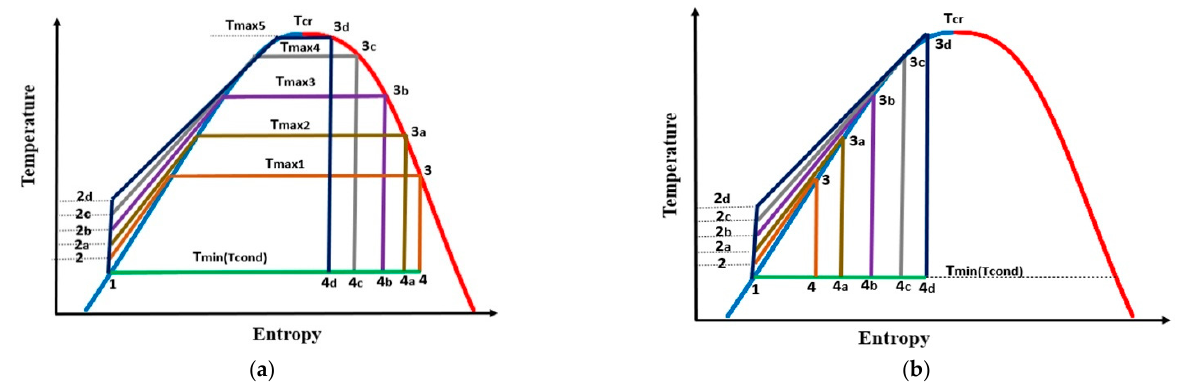
Figure 3. Steps of the efficiency-calculation for ORC ( a ) and TFC ( b ) cycles.